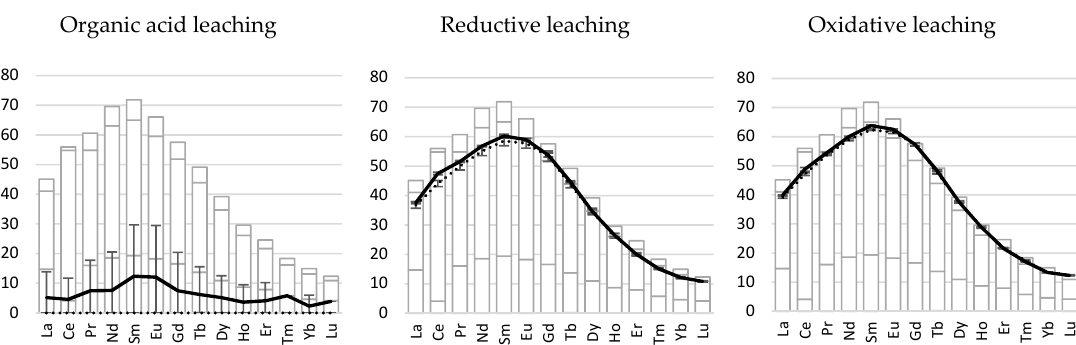
Figure 6. Recovery (%) of individual REE from high-Ca bauxite for each of the leaching techniques tested. Solid lines represent inoculated tests and dotted lines are uninoculated controls. Error bars are plus or minus one standard deviation of triplicate experiments. Bar charts show sequential extraction data, as in Figure 4.